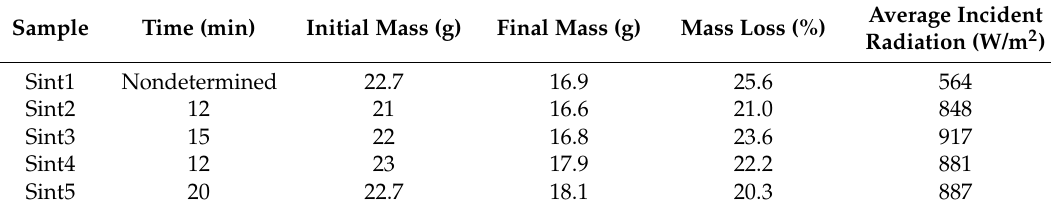
Table 3. Experimental conditions for the iron ore agglomeration.